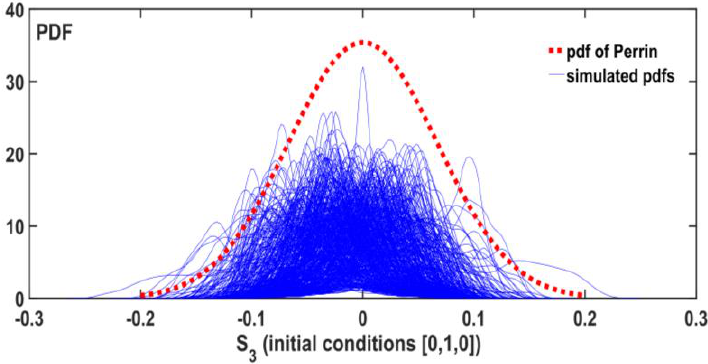
Figure 9. Perrin’s pdf and simulated pdfs for a linear SOP.